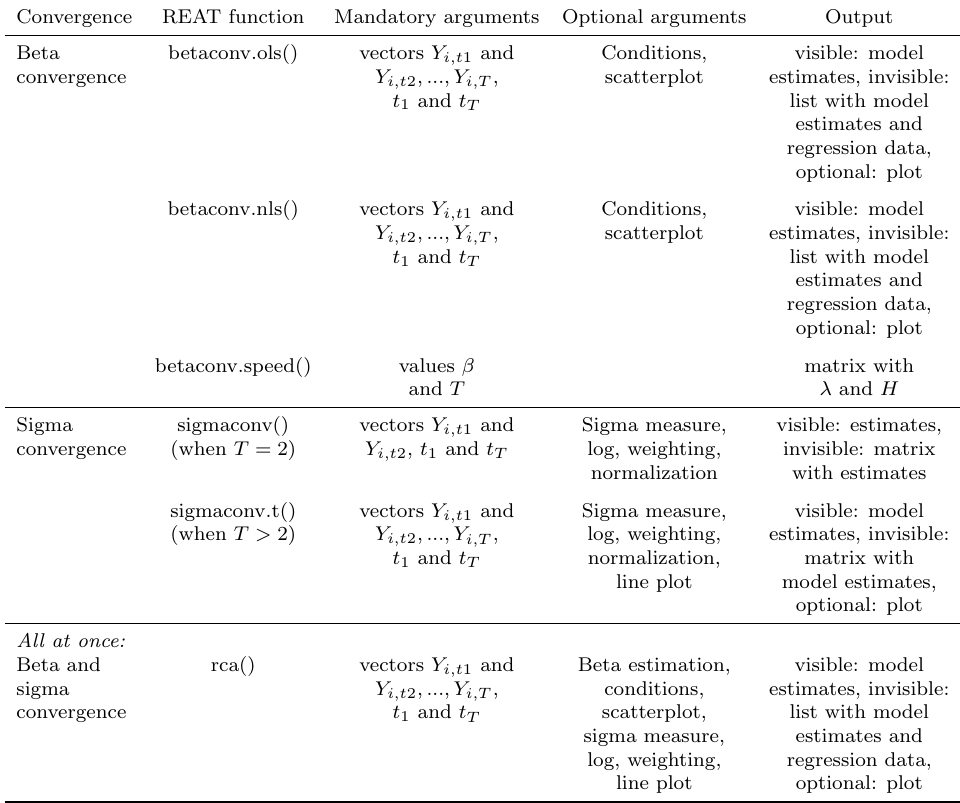
Table 4: REAT functions for beta and sigma convergence